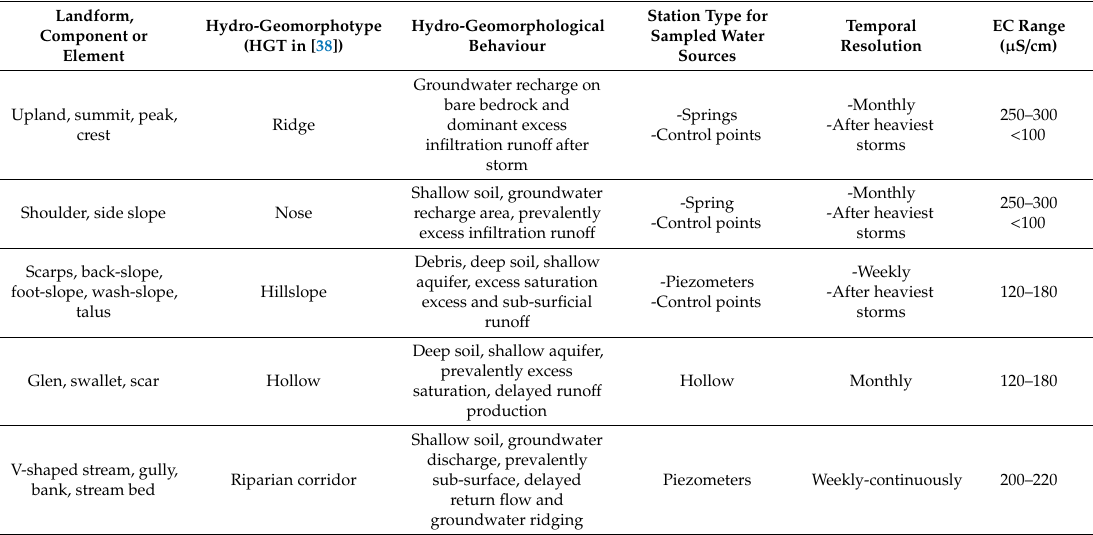
Figure 3. Expert-based hydro-geomorphological map of the catchment depicting the morphological units significant as hydro-geomorphotypes. In black, the hydrogeological features are as in Figure 2, and arrows represent the surveyed sub-surface flow. Table 1. Landforms, hydro-geomorphotypes and electrical conductivity ranges (modified from